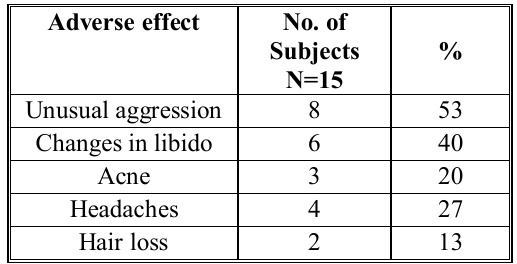
Table 6: Adverse effects reported by AAS- using